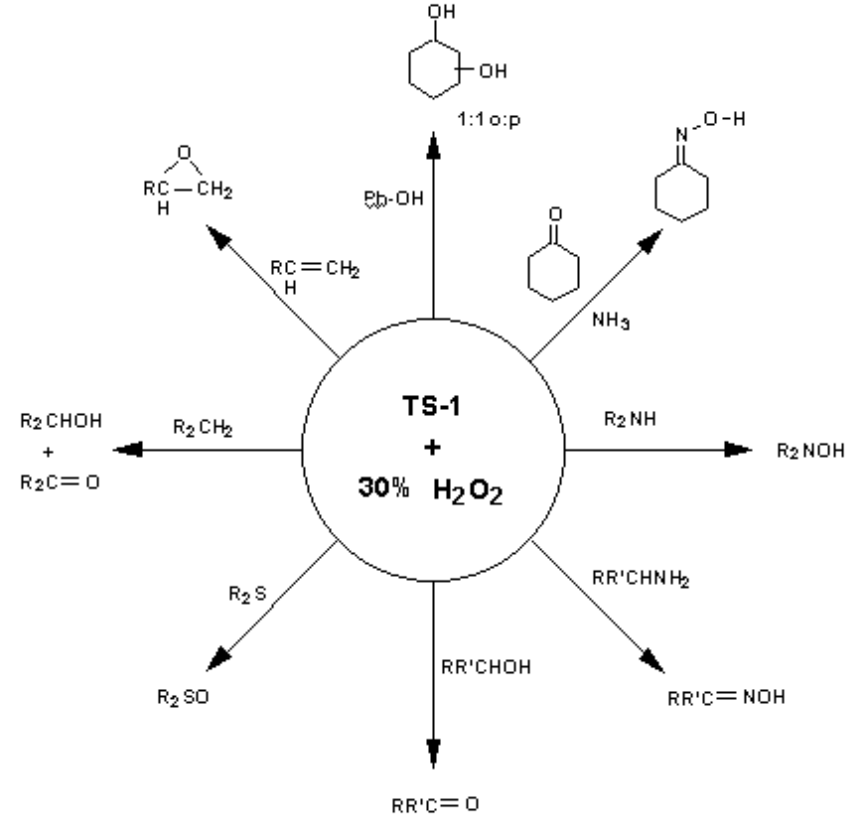
Figure 1: Schematic representation of the most relevant oxidation reactions catalyzed by TS-1.